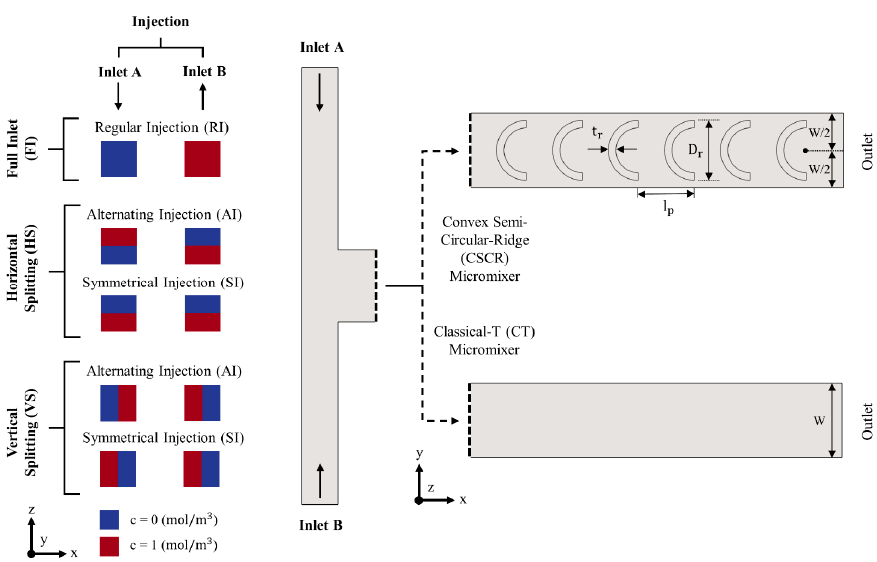
Figure 2. Inlet types, injection modes and 2-D micromixer geometries.